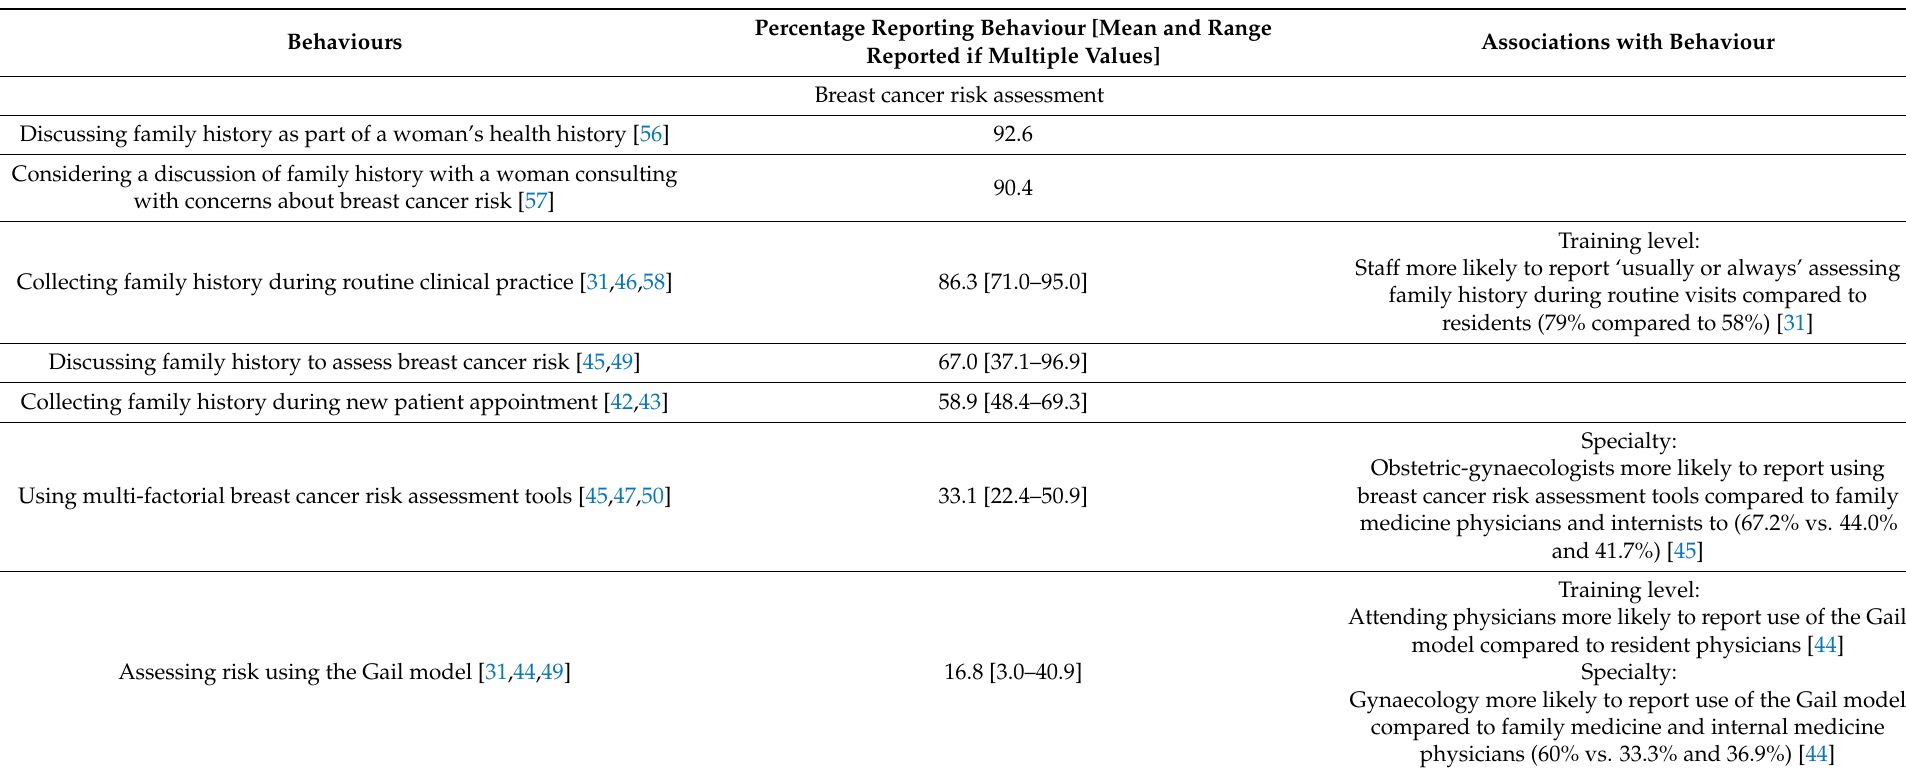
Table 5. Primary care providers’ reported behaviours with respect to breast cancer risk